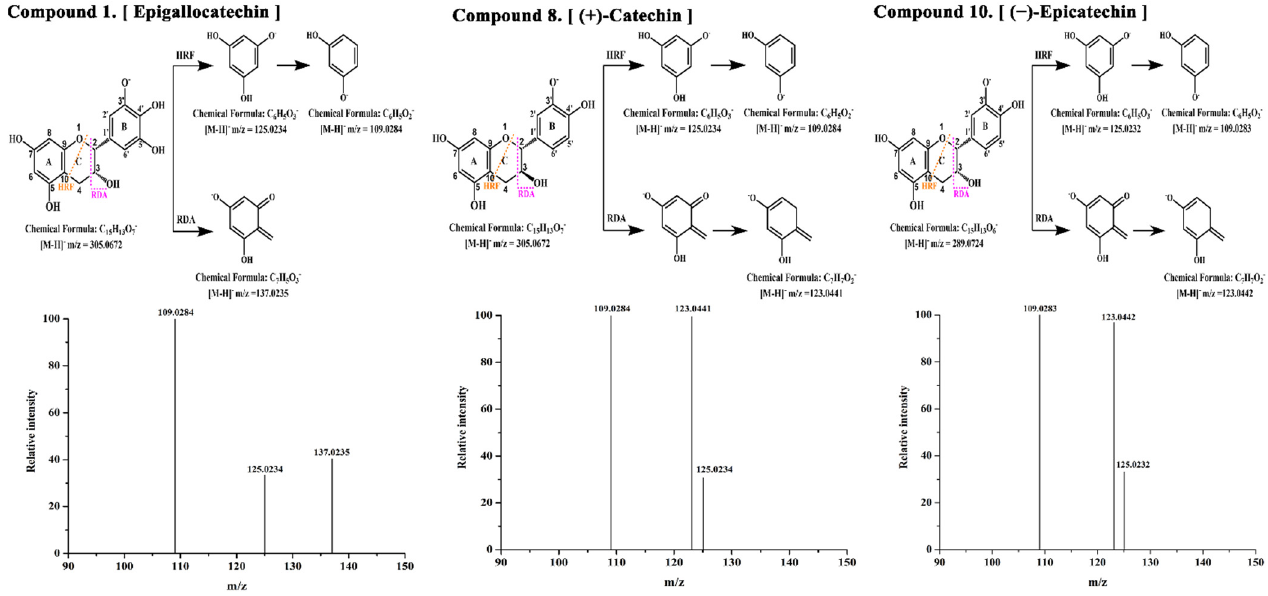
Figure 3. The secondary mass spectra of main polyphenolic compounds epigallocatechin, (+)-catechin and ( − )-epicatechin, respectively, in negative ion mode.